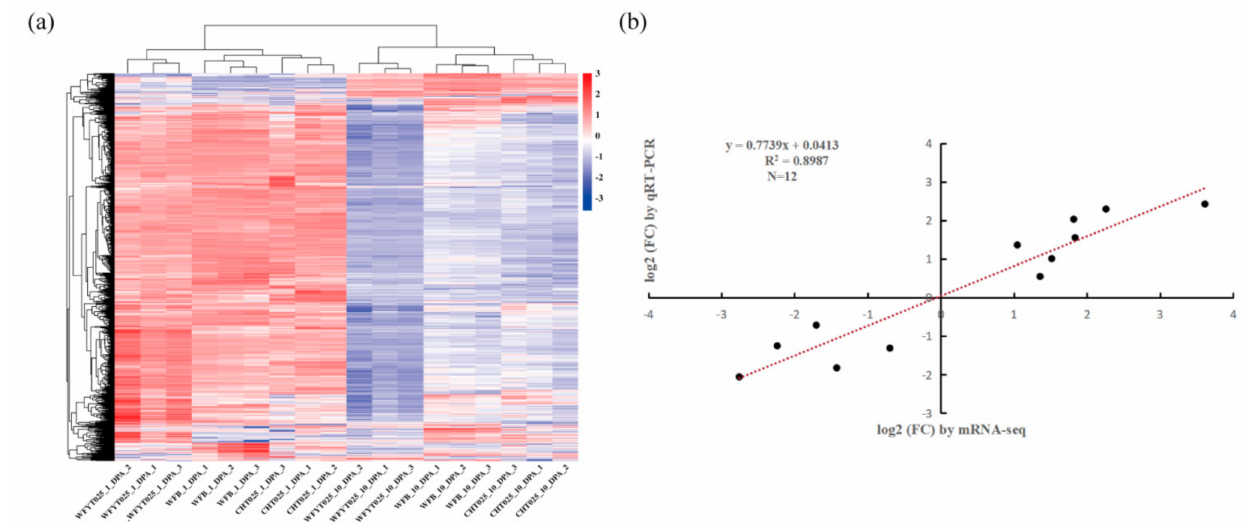
Figure 4. ( a ) Hierarchical clustering analysis of all gene models based on expression data. Each horizontal line refers to a gene. The color key represents FPKM normalized log2 transformed counts. With the color varied from red to blue, the expression of transcripts is from high to low; 1, 2, and 3 stand for the replicated samples from CHT025, WFYT025, and WFB, respectively. ( b ) Comparison of the log 2 (FC) of 12 randomly selected transcripts using RNA-Seq and qRT-PCR. We further analyzed the DEGs via pairwise comparisons between WFYT025 and the parents at two stages of grain development. At 1 and 10 DPA, 2289 and 1995